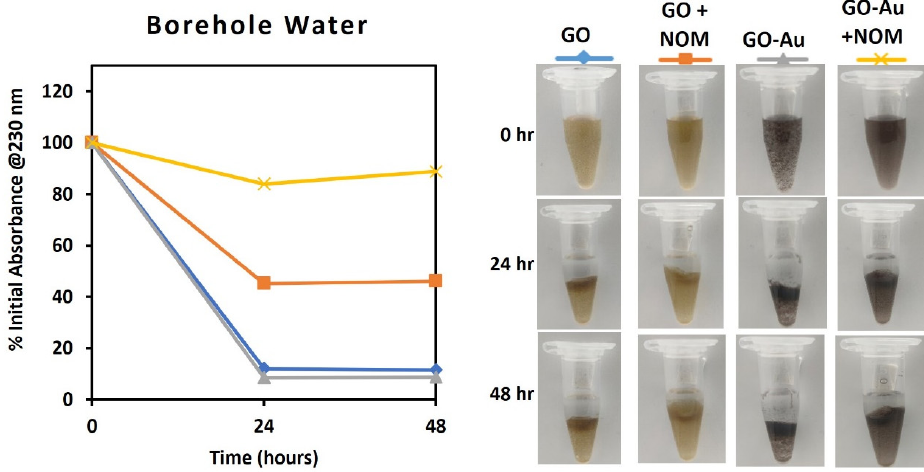
Figure 5. Monitoring of dispersion stability of GO and GO-Au in borehole water with and without NOM (20 mg/L). ( left ): Absorbance measured in UV-vis; ( right ): Photographs for visual observation.